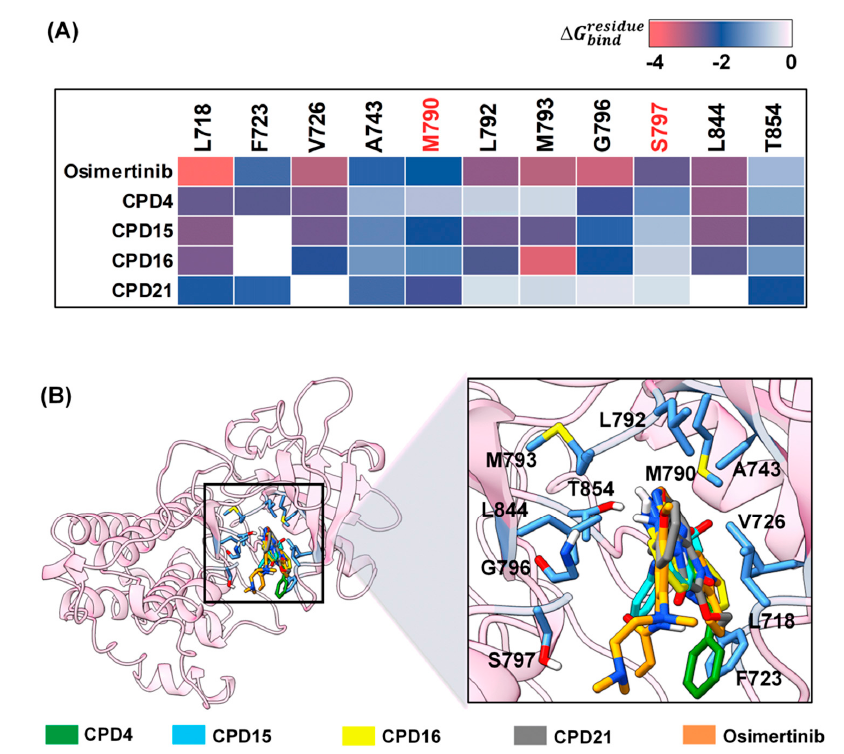
Figure 6. Binding free energy decomposed to each residue (only some key influential amino acids were shown). ( A ) The level of residue contribution was shaded in a red-blue-white color scale, which was ranging from higher to lower contribution, respectively. Note that the mutated amino acids were shown in red word. ( B ) A close-up view of key influential amino acids contributing to ligand binding in complex with screened compounds and osimertinib.